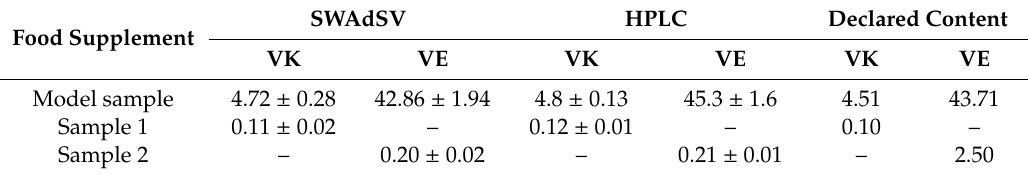
Table 2. Comparison of SWAdSV with HPLC for the analysis of selected food supplements. SWAdSV Food Supplement